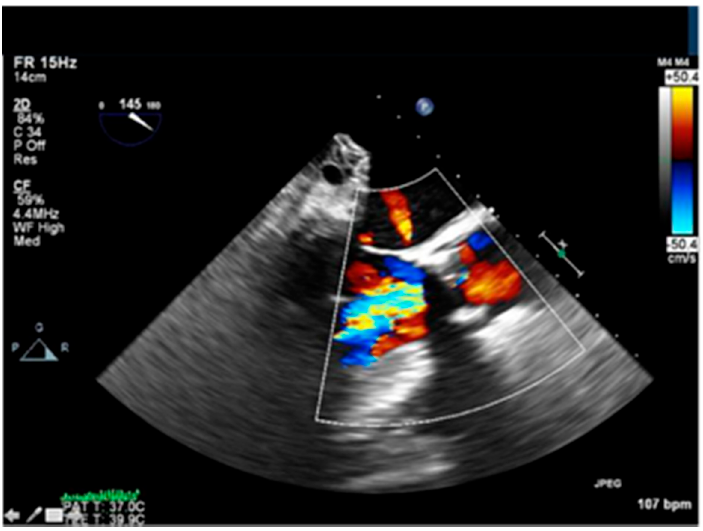
Figure 3. Intraoperative Trans-esophageal echocardiogram showing severe aortic regurgitation.